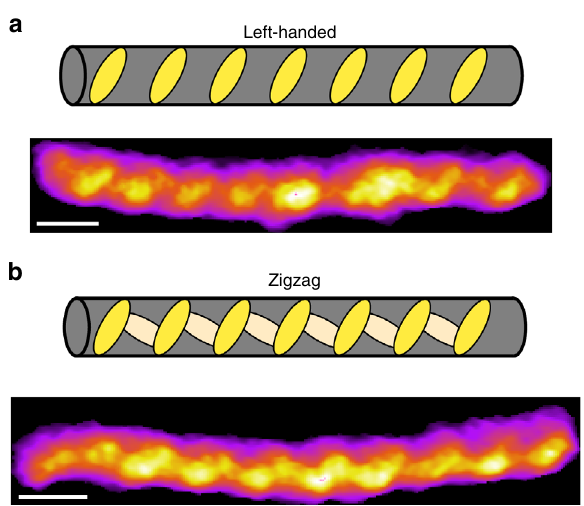
Fig. 4 Subtypes of the Type I G-wires. AFM images and illustrative schematics of the a left-handed and b zigzag subtype of the Type I G-wire. The length scale (white bar) is 5 nm